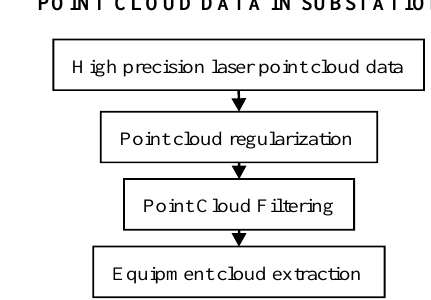
Figure.1 Overall workflow of the